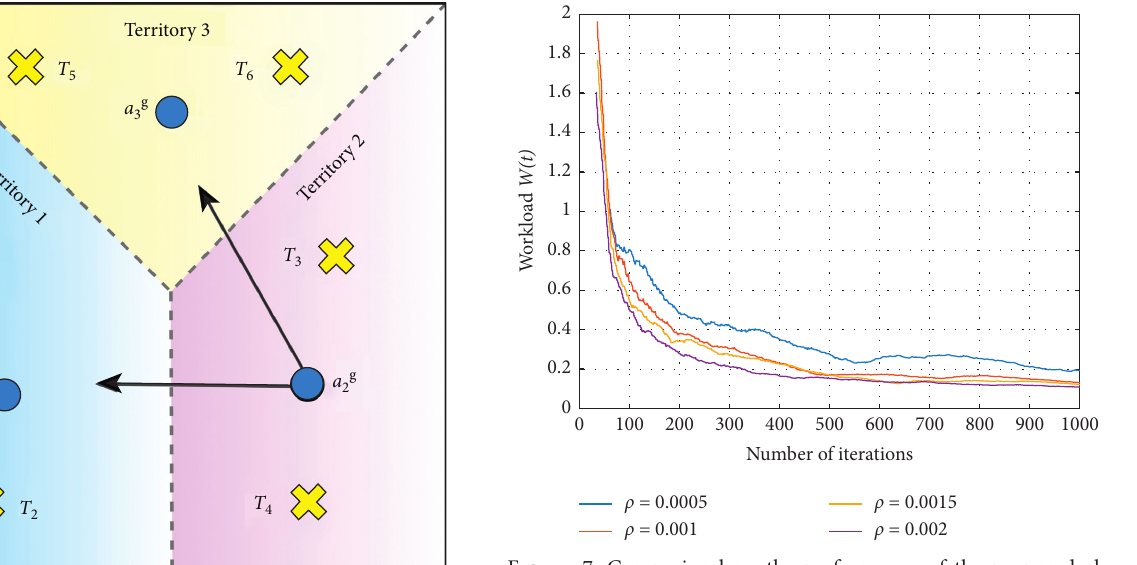
Figure 7: Comparing how the performance of the proposed al- Figure 5: The available actions for a g gorithm varies as the density of the targets in F varies. Performance in the normal-form game. If 2 is measured in terms of the workload W ( t ) the agent chooses φ (territory 2), it means that it has decided to 2 retain the initial territorializing. Otherwise, where l ≠ 2, the agent has decided to deviate from the original partition.